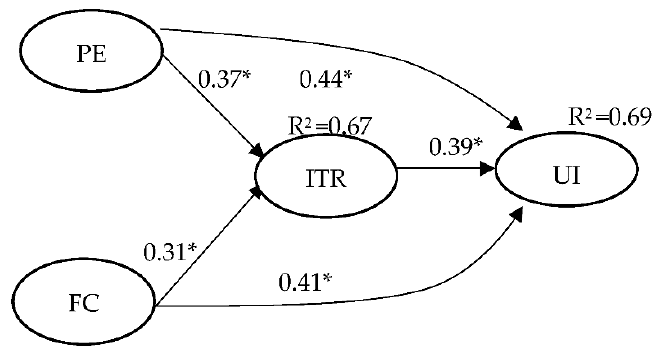
Figure 2. Path coefficients (Direct). * p <